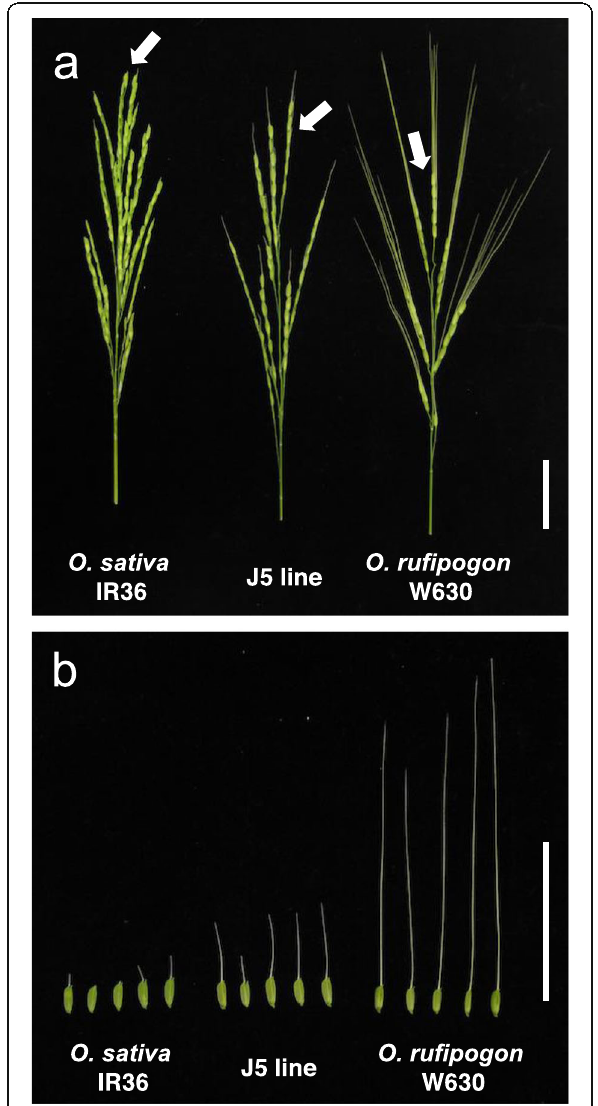
Fig. 1 Panicle and spikelet morphology of the O. sativa IR36, J5 line and O. rufipogon W630. a Whole panicles. Arrows indicate top primary branches in the panicles. b Spikelets on the top primary branches. The 1st to 5th spikelets are arranged from left to right. Scale bar: 5